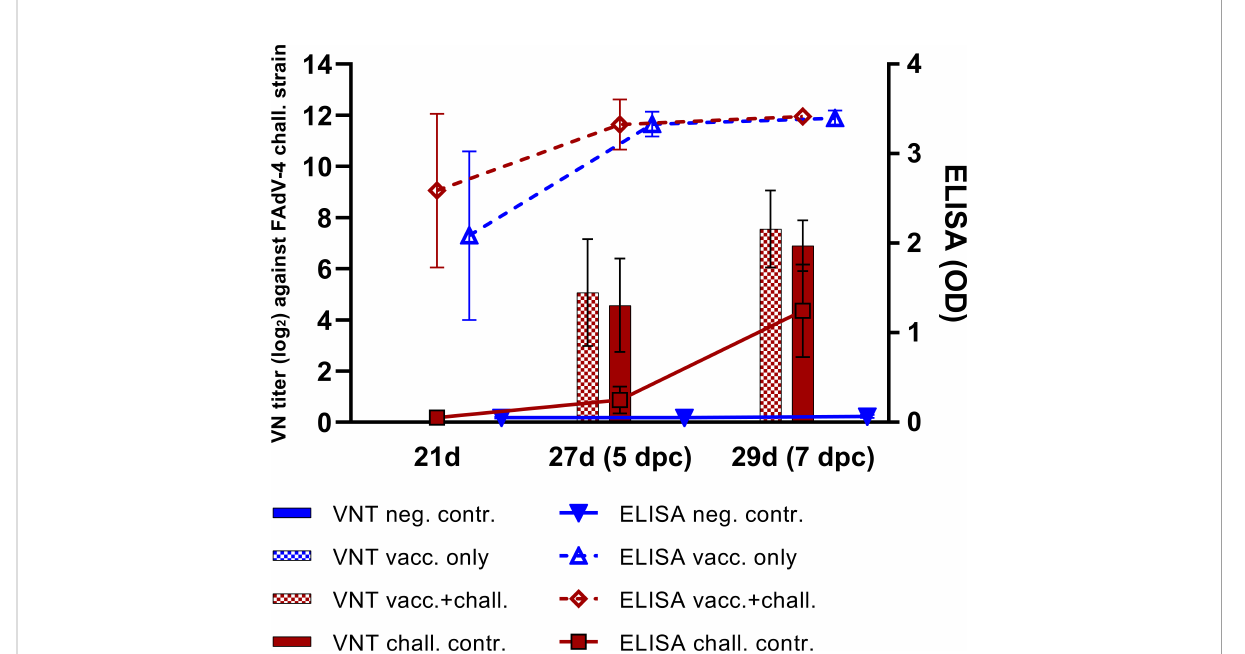
FIGURE 1 Antibody development following crecFib-4/11 vaccination in each experimental group of the animal study. The lines represent mean values of antibodies measured on ELISA plates coated with crecFib-4/11, whereas the bars indicate VN titers against the FAdV-4 challenge strain. No neutralizing antibodies were detected in the vaccinated only and the negative control groups at any time point. Reprinted from: Vaccination with a fowl adenovirus chimeric fi ber protein (crecFib-4/11) simultaneously protects chickens against hepatitis-hydropericardium syndrome (HHS) and inclusion body hepatitis (IBH), Vaccine (2022) 40, De Luca C, Schachner A, Heidl S, Hess M, pages no. 1837 – 45, Copyright © 2022 Elsevier B.V. or its licensors or contributors, with permission from Elsevier